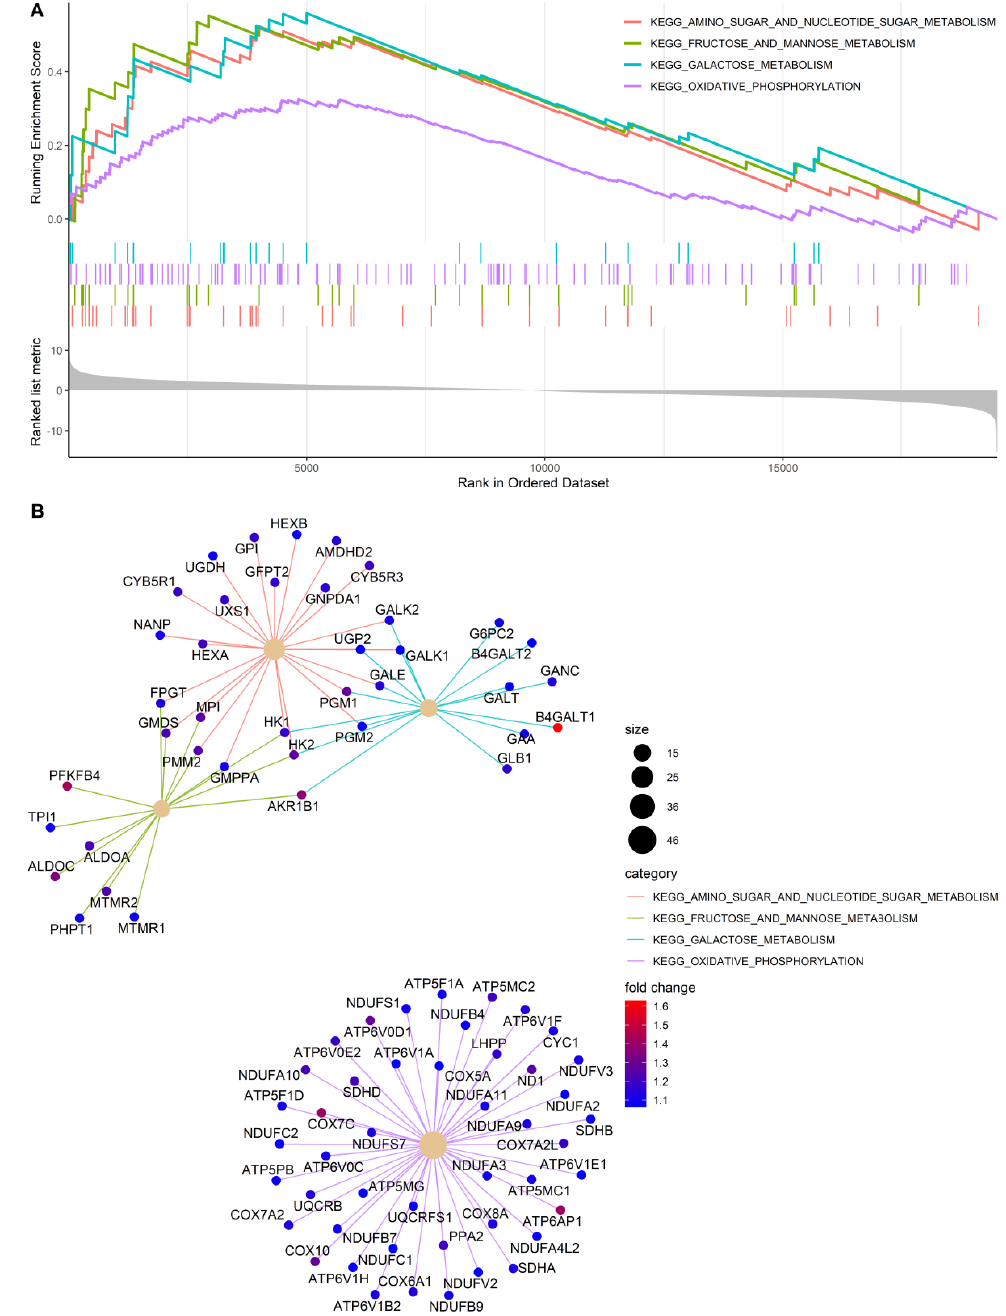
Figure 7. Metabolic pathways significantly activated following PDK1 silencing in OVCAR3 tumors by GSEA. ( A ) Enrichment plots of the four metabolism-related KEGG pathways significantly activated in tumors formed by OVCAR-3 cells bearing PDK1 silencing. GSEA results are visualized in terms of running enrichment scores and preranked lists. ( B ) Gene-concept network showing the significant genes contributing to the positive enrichment of the four metabolism-related KEGG pathways and their fold changes (color ramp on side). The size of the nodes representing the categories is proportional to the number of genes contributing to their enrichment. Interestingly, while the activation of oxidative phosphorylation pathway is determined by a distinct set of genes, the other three metabolic pathways (i.e., amino sugar and nucleotide sugar metabolism, fructose and mannose metabolism and galactose metabolism) appear strongly interconnected with several shared core genes.